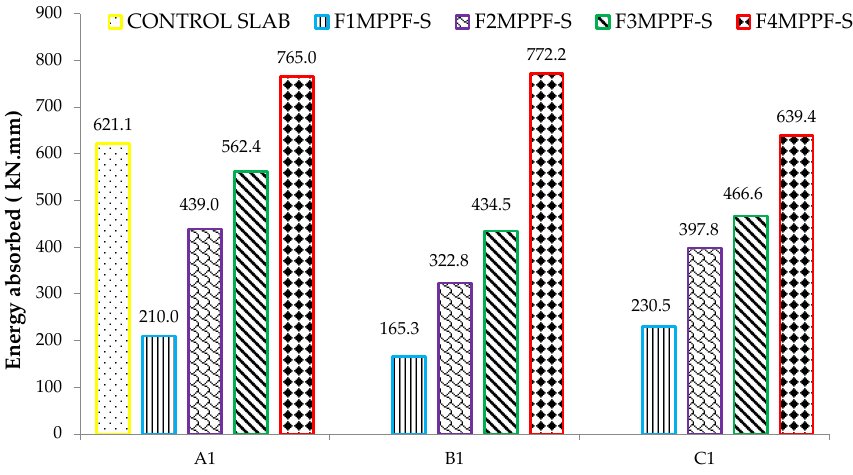
Figure 21. Absorbed energy of ferrocement and control slab.